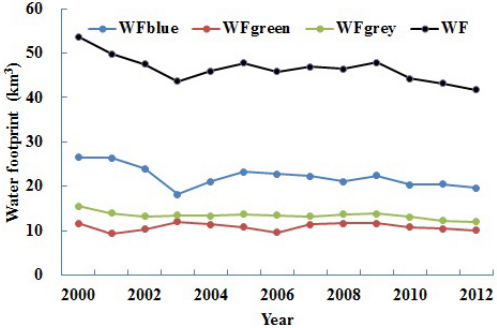
Figure 3. WF of crop production in the HSP from 2000 to